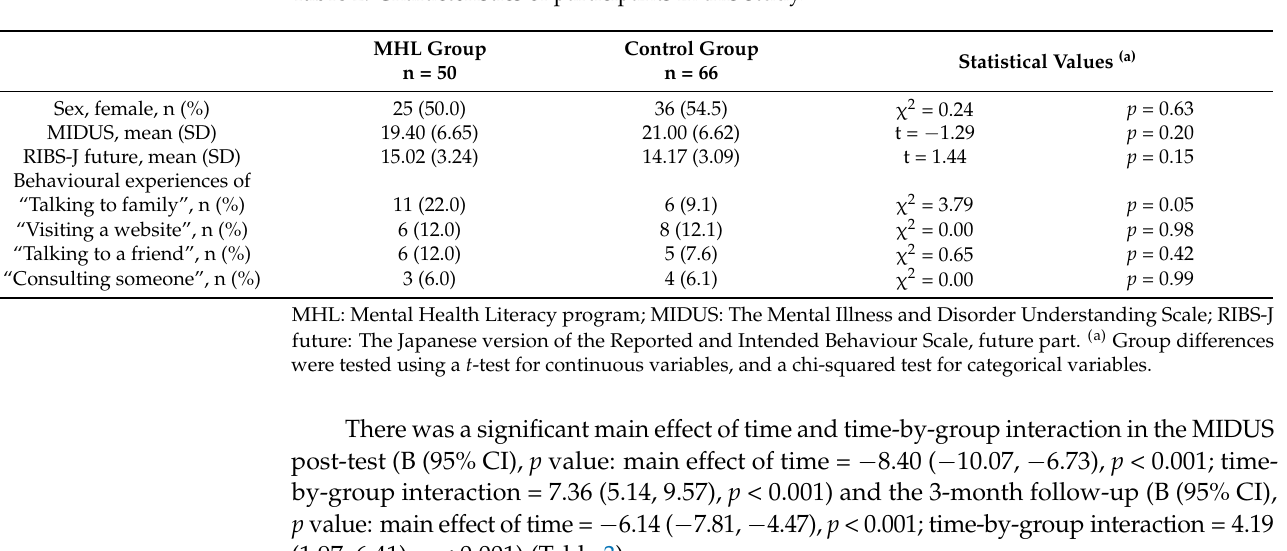
Figure 1. Flowchart of the survey. Table 2. Characteristics of participants in this study.